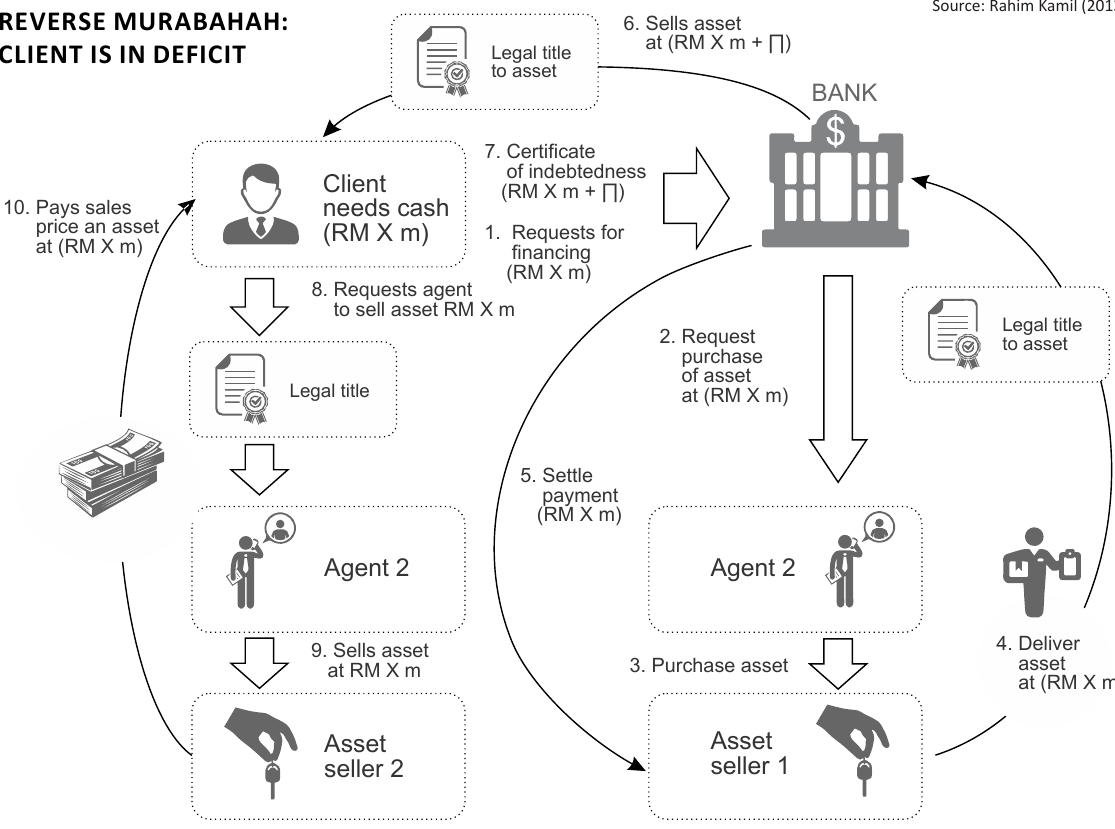
Figure 3. The transactional flow of reversed